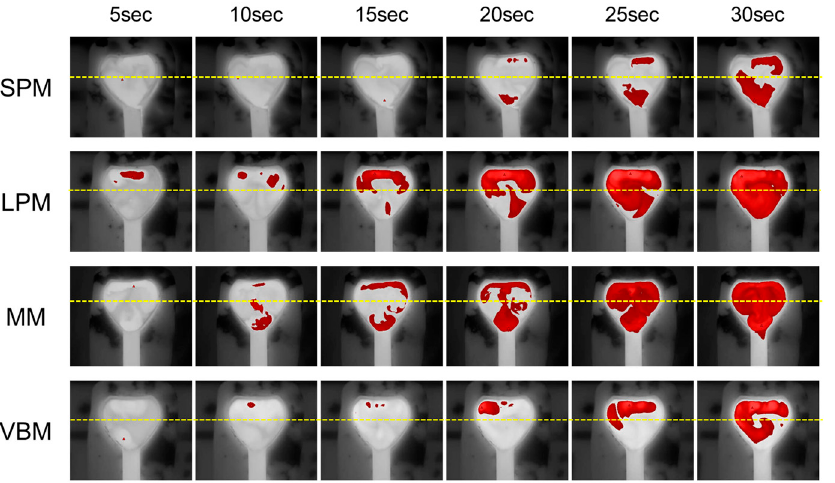
Figure 3. Examples of high-temperature area distributions. The red areas show high temperatures above the threshold. The yellow lines indicate the boundary between the region anterior and posterior of the laser tip. SPM: short pulse mode; LPM: long pulse mode; MM: Moses mode; VBM: virtual basket mode.